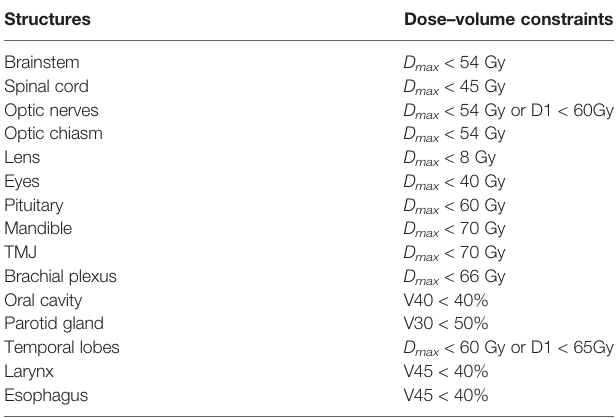
TABLE 1 | Clinicopathological characteristics of the patients with nasopharyngeal carcinoma (NPC).